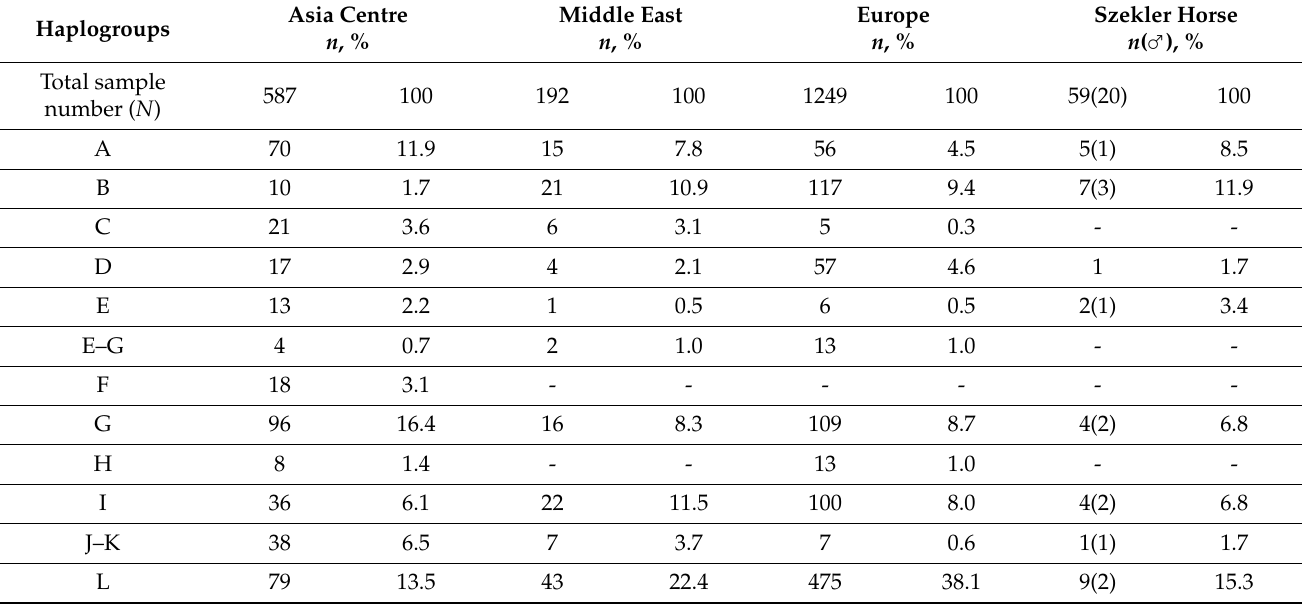
Table 1. Haplogroup frequencies of Szekler horse compared with the former results